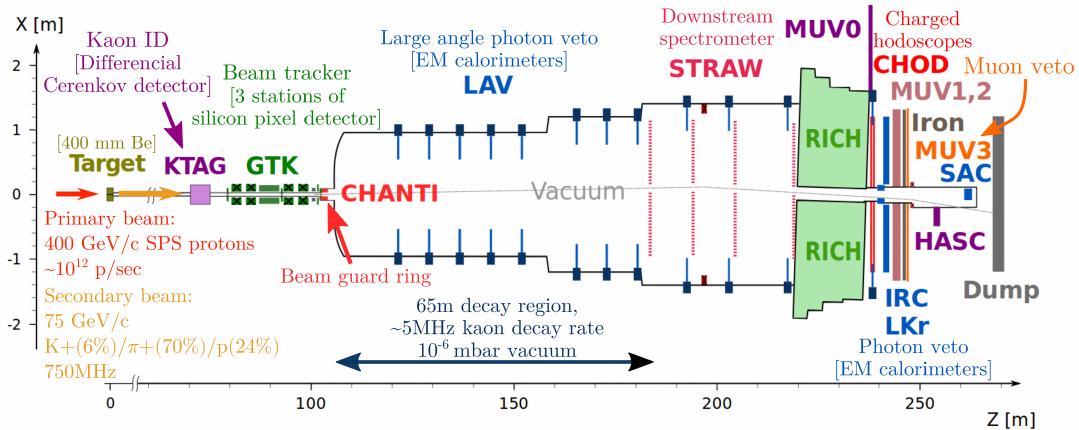
Figure 1. NA62 schematic layout; all the detectors are visible